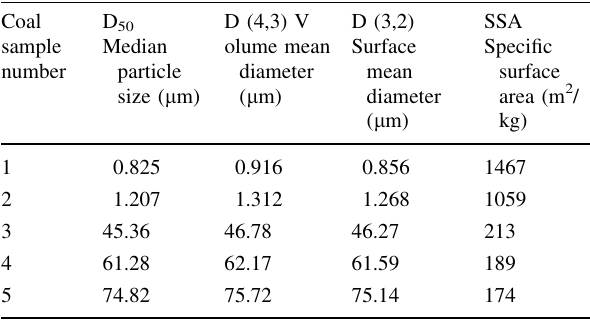
Table 1 Coal sample particle size test